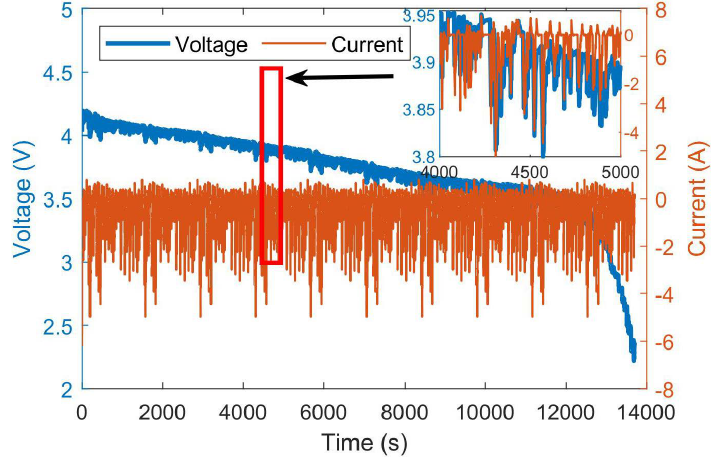
Figure 2. Current and voltage of the UDDS